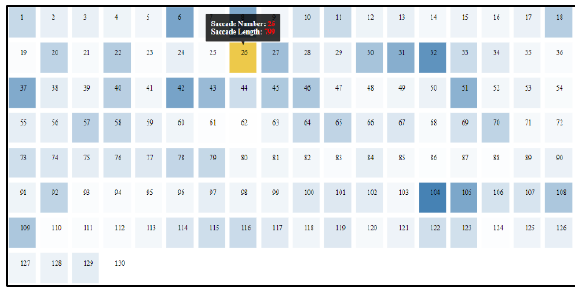
Figure 2: Longest saccade selection with the rectangles